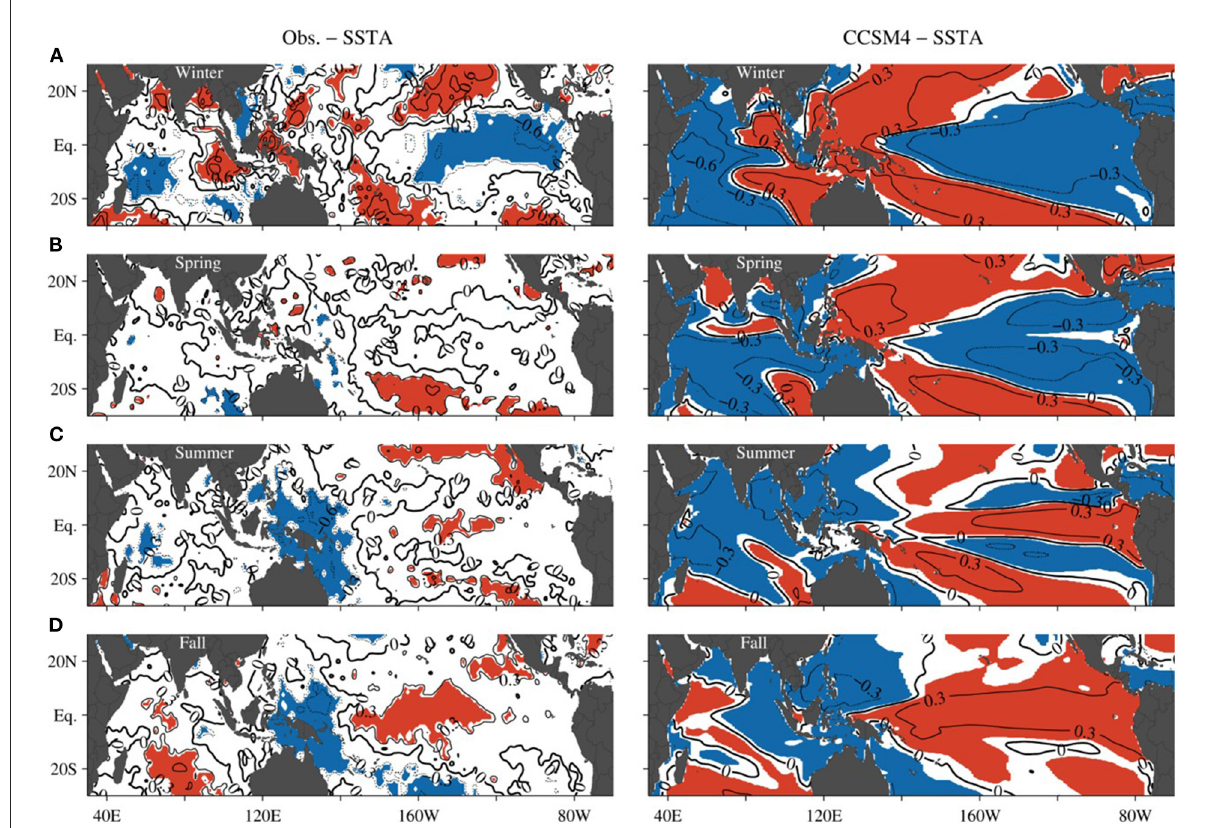
FIGURE4 Comparison of observed (left column) and simulated (right column) lag correlations between the SSTA in STIO in fall and the tropical Indo-Pacific SSTA in the following four seasons during the positive phases of the decadal variability (from 1945 to 2009 in the observation). (A) Winter (December to February). (B) Spring (March to May). (C) Summer (June to August). (D) Autumn (September to November). The contour interval is 0.3. Red and blue shades indicate 95% confidence level of positive and negative correlation, respectively. The model correlations are nearly everywhere above the 95% significance level due to the long time